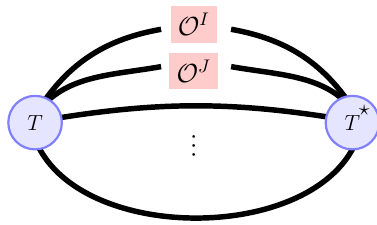
Figure 14. Contraction in equation (6.10).